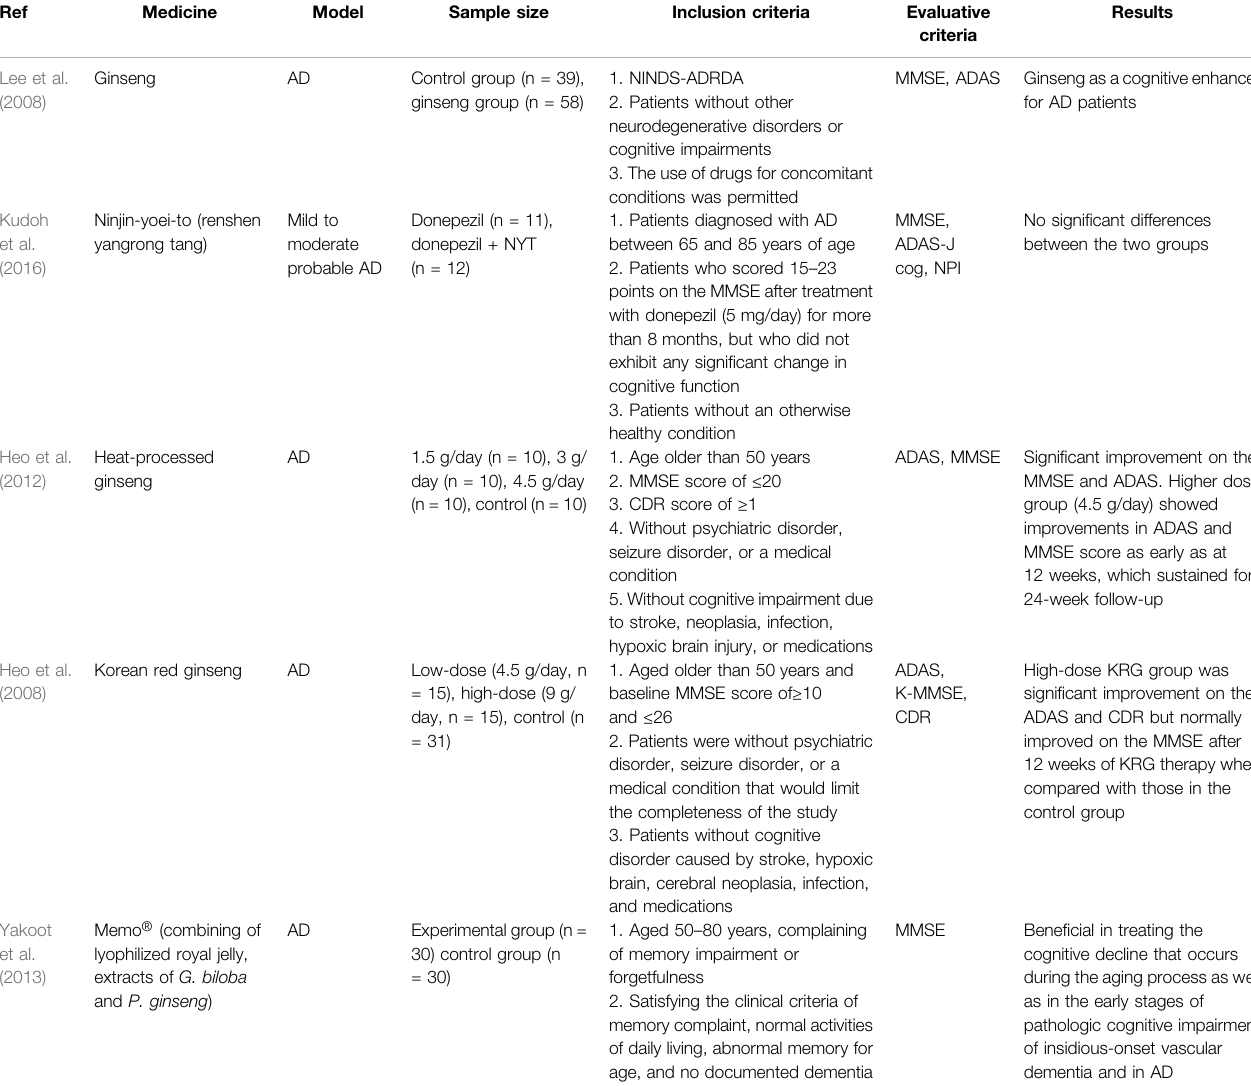
TABLE 4 | Summary of clinical trials of ginseng interventions in AD